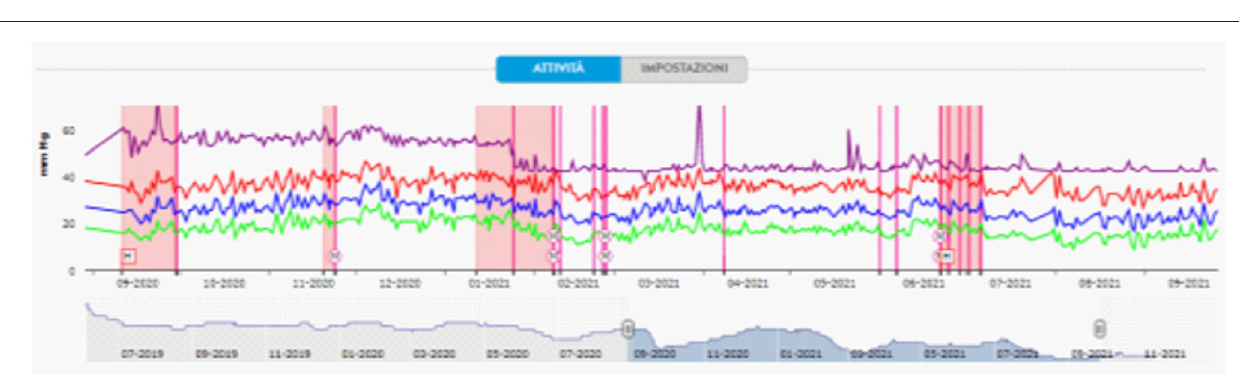
FIGURE 4 | Pulmonary artery pressure tracing detected by CardioMEMS. Starting from September 2020, there was a progressive shortening of the time between hospitalizations (pink squares) for levosimendan infusions. Pulmonary artery pressure tracing showing a mean diastolic PA drop after Optimizer Smart ® implantation (January 2021). M and/or purple lines, remote therapy modifications; H,